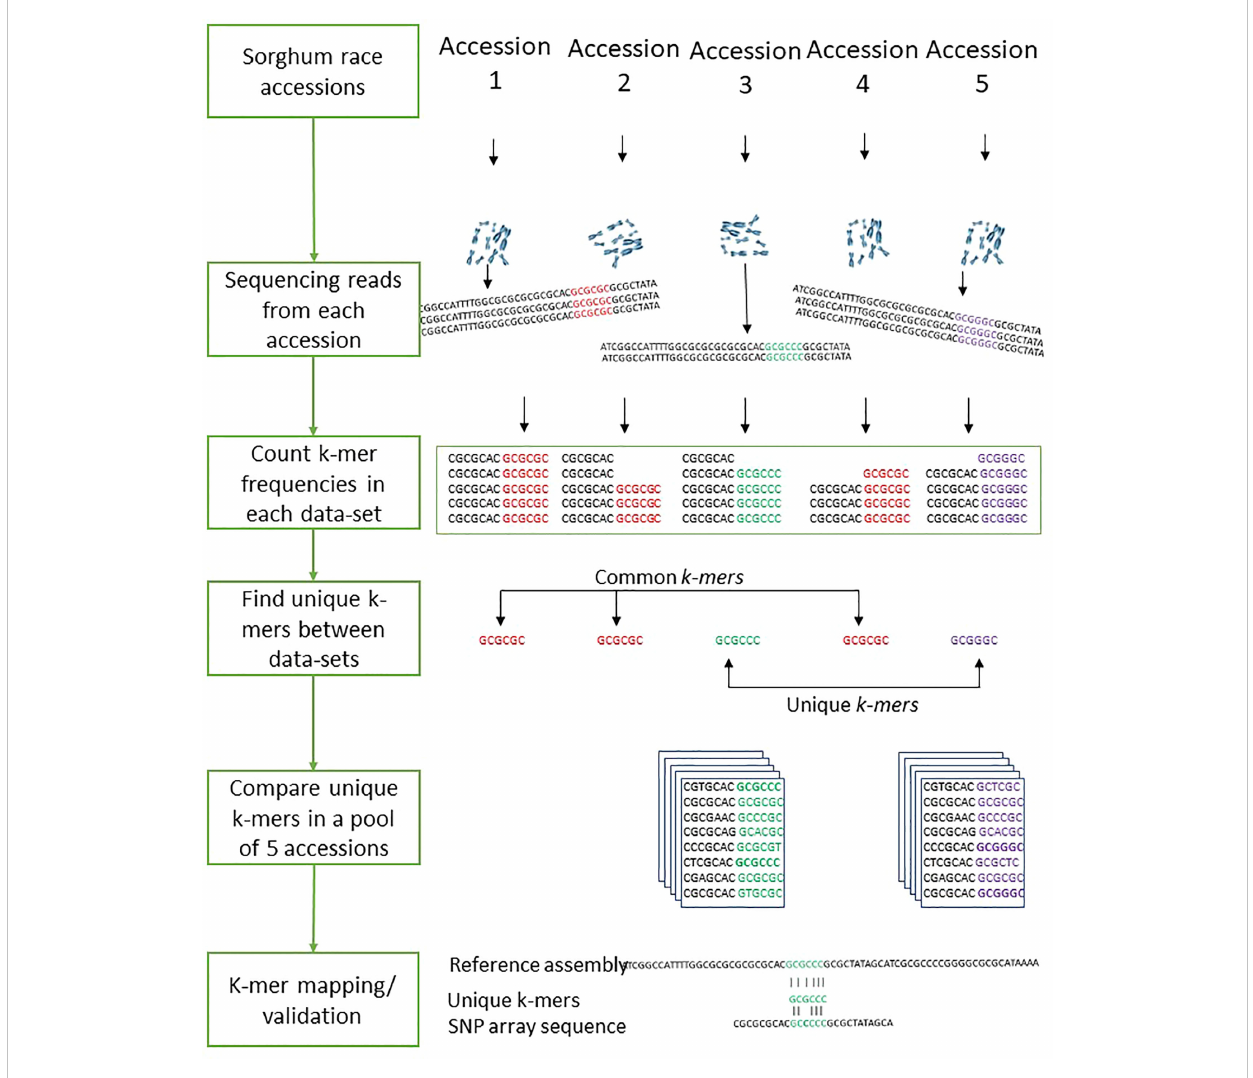
FIGURE 7 The work fl ows of the sorghum race accessions comparison with k-mer